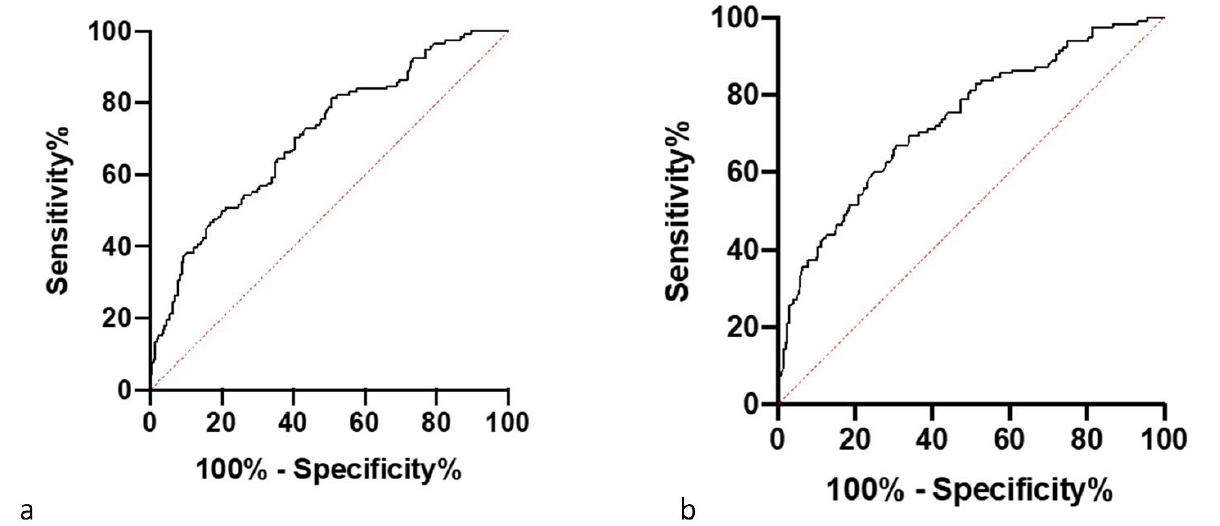
Figure 9. ( a ) An ROC curve showing the sensitivity and specificity of different threshold values in determining whether a cow is lame based on the data collected on the maximum ambient adjusted temperature calculated from the residuals from the average healthy foot temperature on each data collection day collected by the CAT s62-Pro Smartphone (LCD). ( b ) An ROC curve showing the sensitivity and specificity of different threshold values in determining whether a cow is lame based on the data collected on the maximum ambient adjusted temperature calculated from the residuals from the average healthy foot temperature on each data collection day collected by the FLIR T620bx (HCD). Table 4. Calculated sensitivity, specificity, and positive predictive and negative predictive values from optimum thresholds calculated using an ROC curve using maximum adjusted temperature of a cattle foot, calculated from the residuals from the average healthy foot temperature on each data collection day, and the temperature difference between the hind limbs of a cow, for both the CAT s62-Pro Smartphone (LCD) and the FLIR T620bx